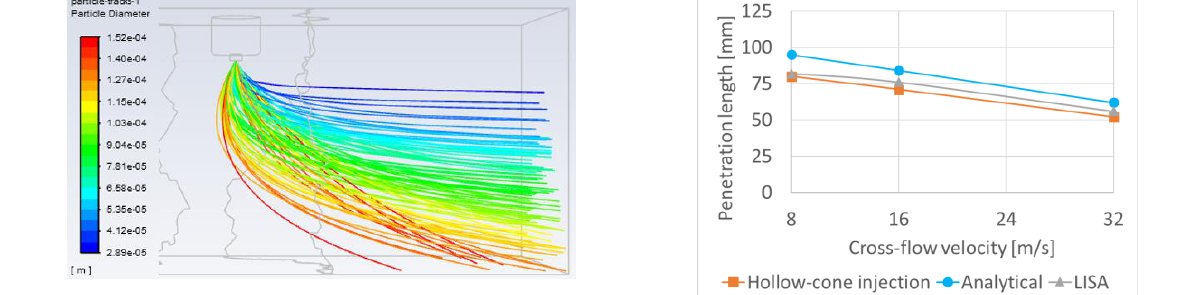
Fig. 9. Particle tracks for LISA for 16 m/s